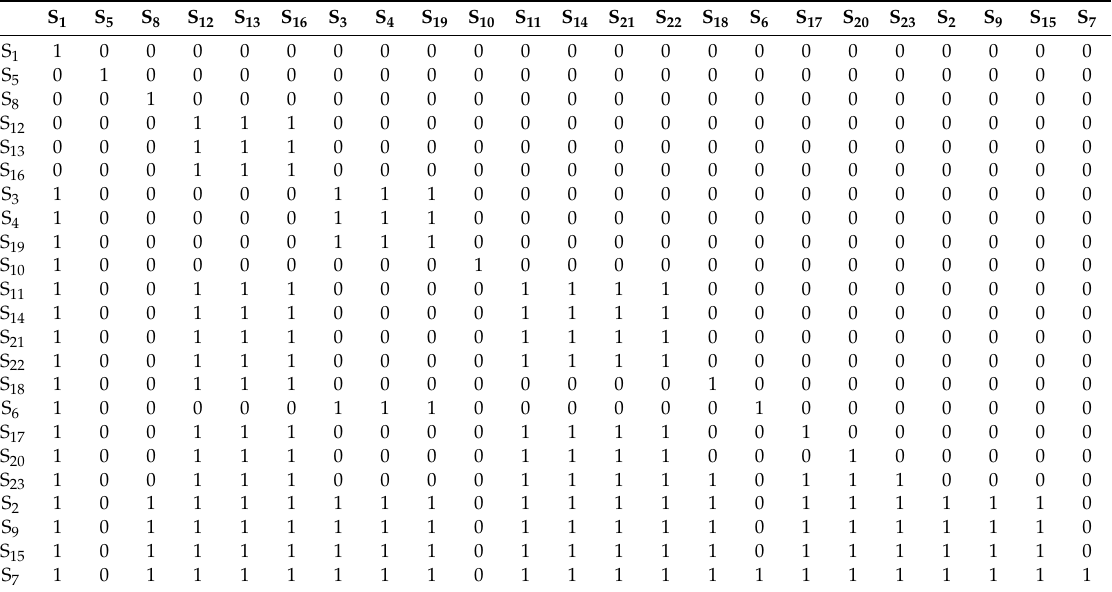
Table 5. The inter-level accessibility matrix of super-gentrification dynamic